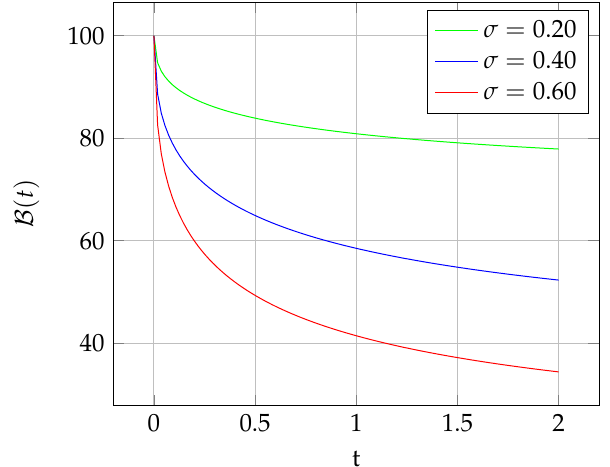
Figure 1. The numerical approximation of B ( t ) : K = 100, T = 2, r = 0.05, δ = 0 and σ = 0.2, 0.40,